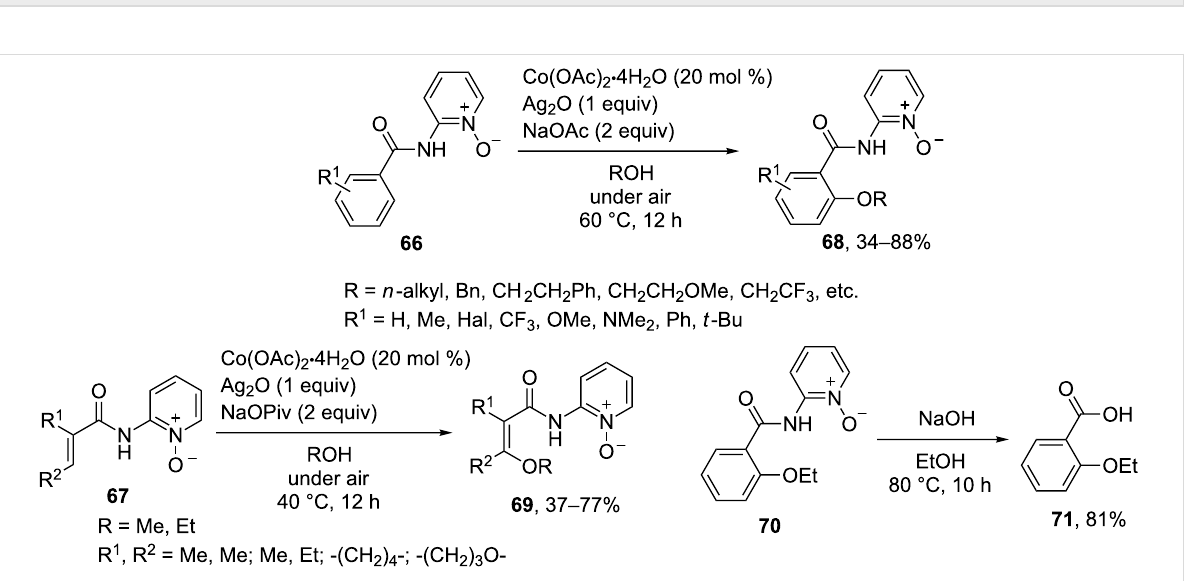
Scheme 14: Cobalt-catalyzed aerobic alkoxylation of arenes and alkenes containing pyridine N -oxide